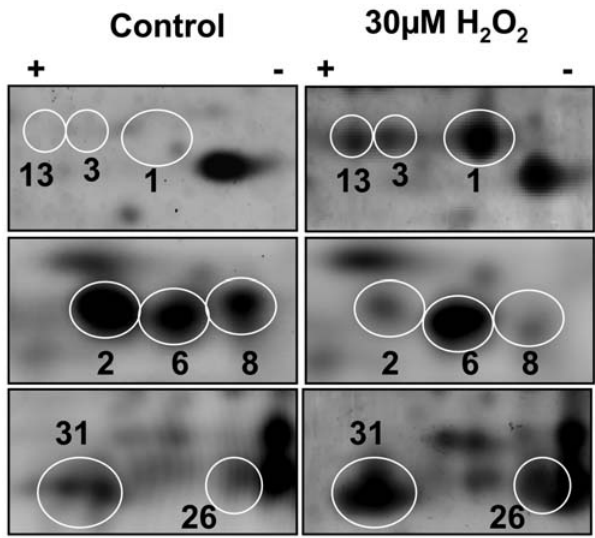
Figure 3. Post translational modification is a common feature in S.solfataricus . Three of the proteins that are regulated after H 2 O 2 treatment are known to be important in oxidative stress and were found in multiple gel spots. Modifications can alter the pI and MW position on 2D gels. The paired panels show close ups of SyproRuby stained 2D gels, 105 minutes after addition of 30 m M H 2 O 2 . Top, DPSL (SSO2079; 21639 Da; pI 5.25) spots 1, 3 and 13. Middle, Rubrerythrin (SSO2642; 16081 Da; pI 5.44) spots 2, 6 and 8. Bottom, Peroxiredoxin (SSO2121; 24786Da; pI 6.85) spots 26 and 31.